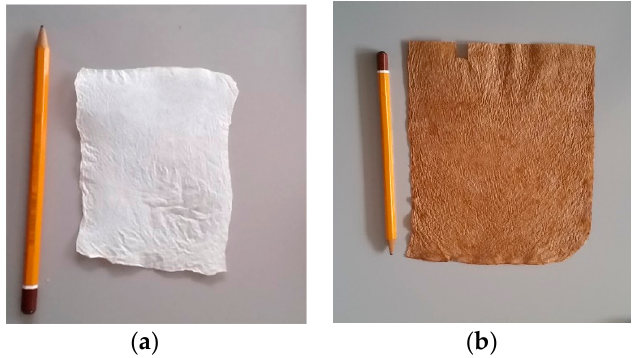
Figure 1. Pictures of different aspects of Bacterial Cellulose (BC). ( a ) BC gel after purification. ( b ) BC dried on gypsum at environmental temperature, without any purification.